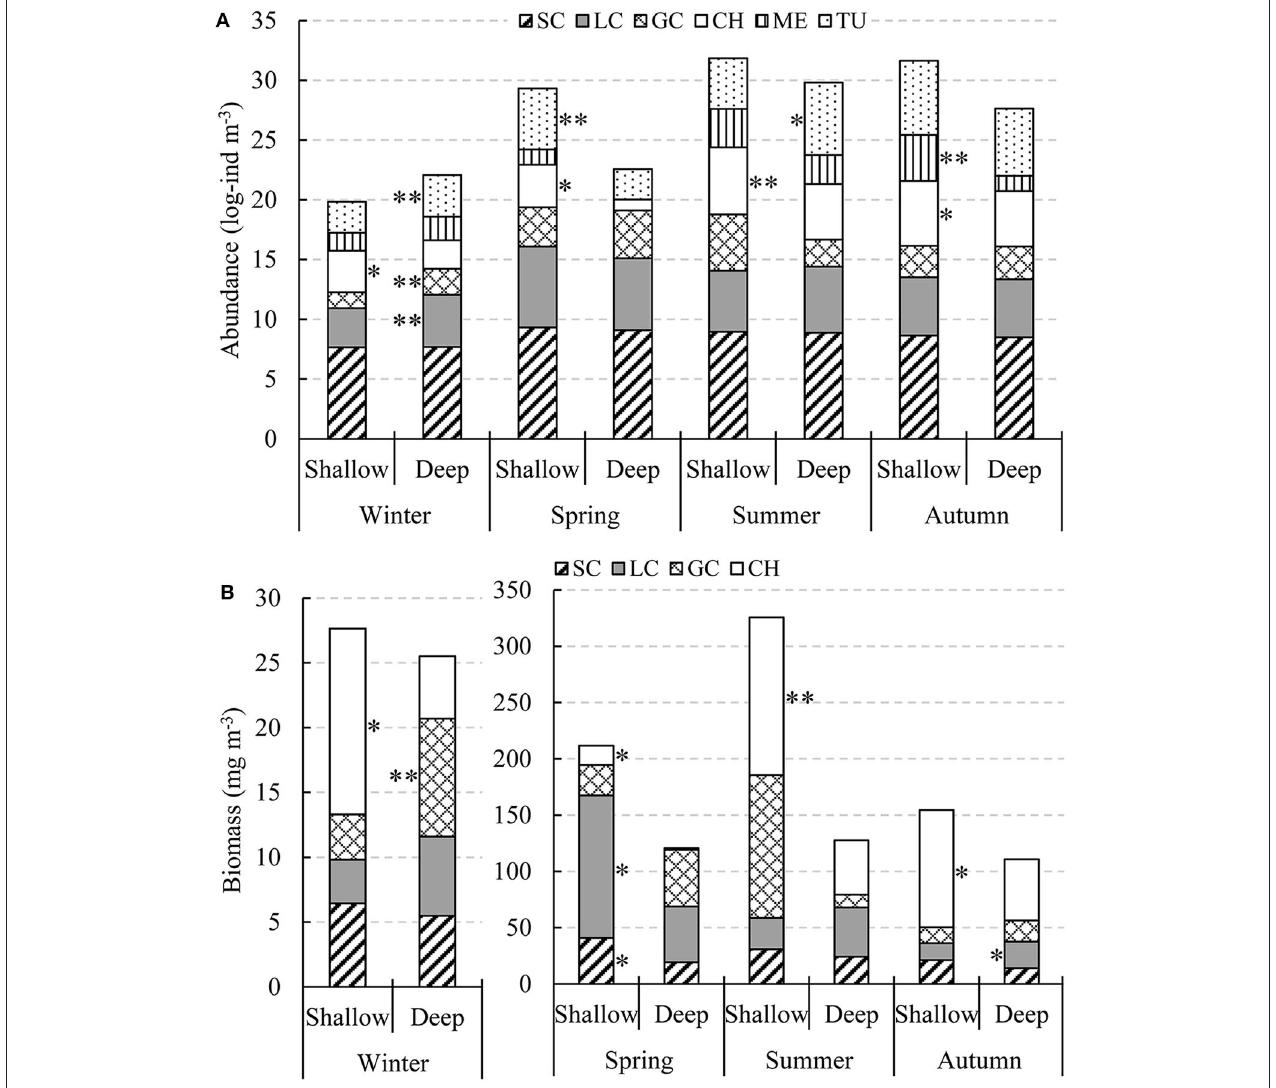
FIGURE 6 | Seasonal changes in log-transformed abundance ( A , log-ind m − 3 ) and biomass ( B , mg DW m − 3 ) of zooplankton taxa in the two domains in the Yellow Sea. * and ** indicate significantly higher zooplankton taxa abundances or biomasses between domains in each season with P < 0.05 and P < 0.01, respectively.